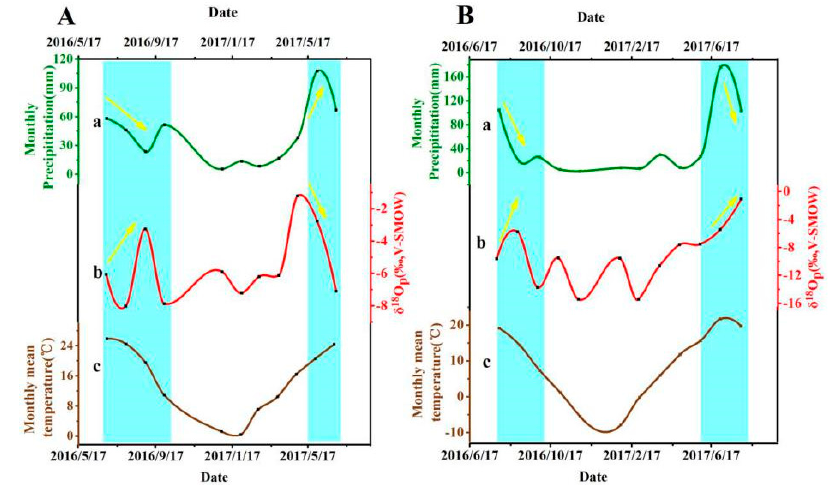
Figure 6. Relationship between monthly weighted mean precipitation δ 18 O and related meteorological factors. ( A , B ) represent Fengxiang and Ningwu, respectively. ( a ) indicates monthly precipitation amount (mm); ( b ) indicates monthly weighted mean δ 18 O value in precipitation ( ‰ , V-SMOW); and ( c ) indicates monthly average surface air temperature (°C).